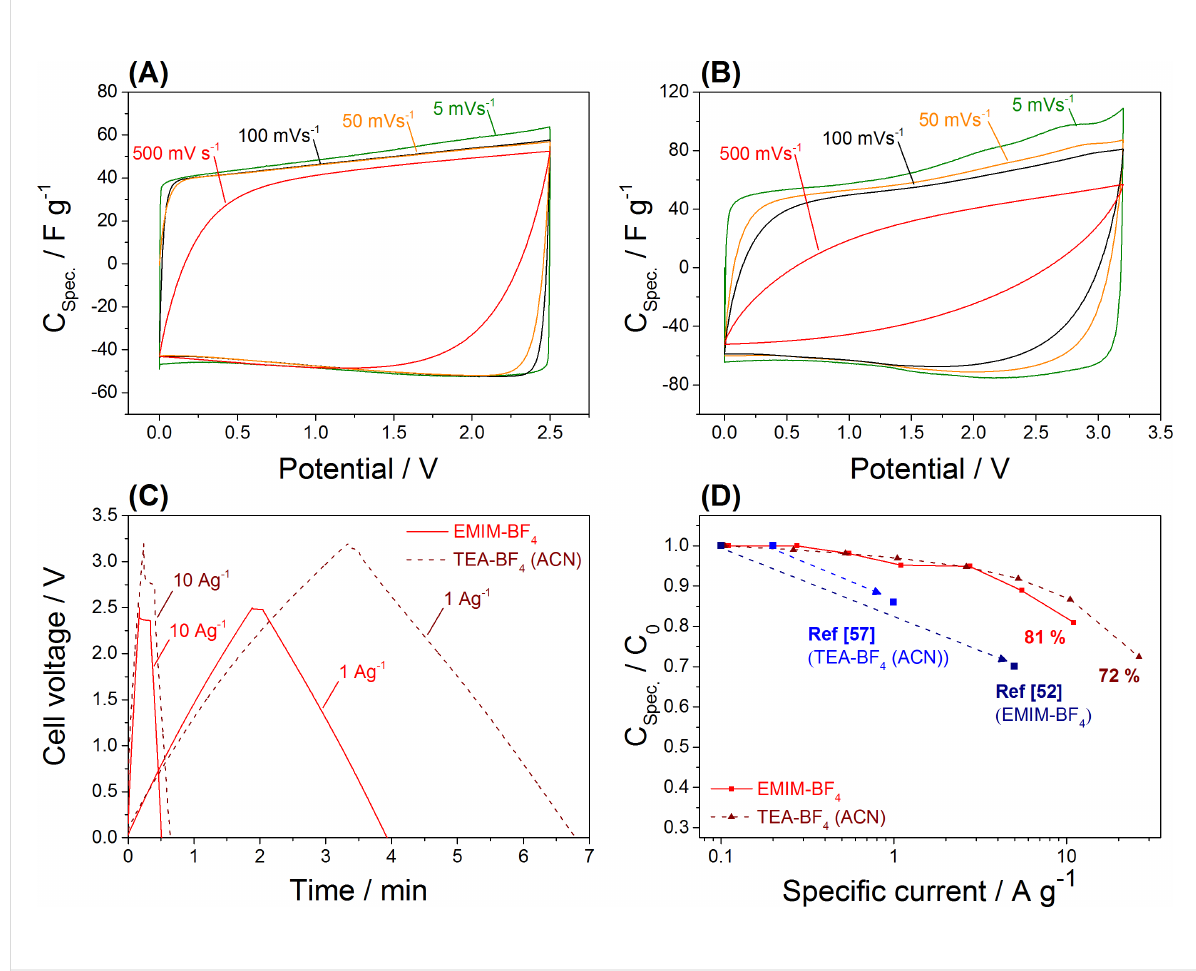
Figure 7: Cyclic voltammograms performed with different scan rates in (A) 1 M TEA-BF 4 (ACN) and (B) EMIM-BF 4 ; galvanostatic charge/discharge curves in two different electrolytes at different specific currents (C); normalized rate capability test with different specific currents (D) in comparison to another Kroll carbon (from [52]) and a mesoporous template carbon (from [57]) with comparable mesopore sizes and surface